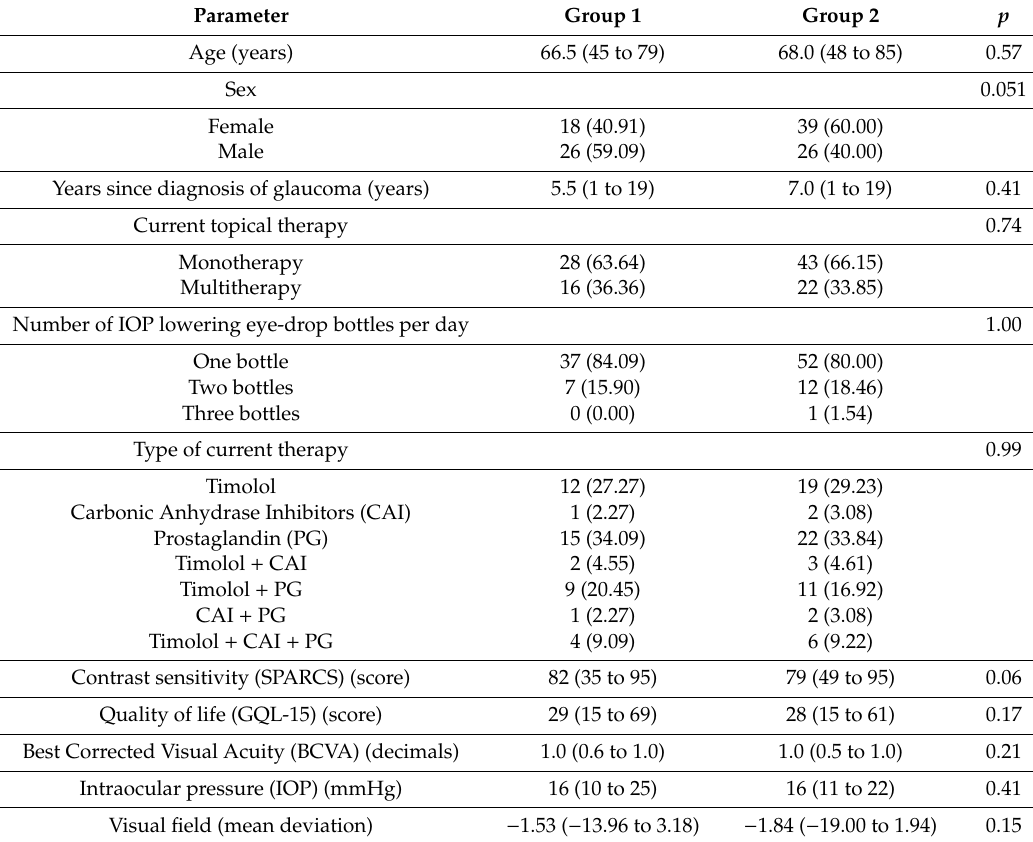
Table 2. Di ff erences between groups at randomization and the baseline demographic and clinical